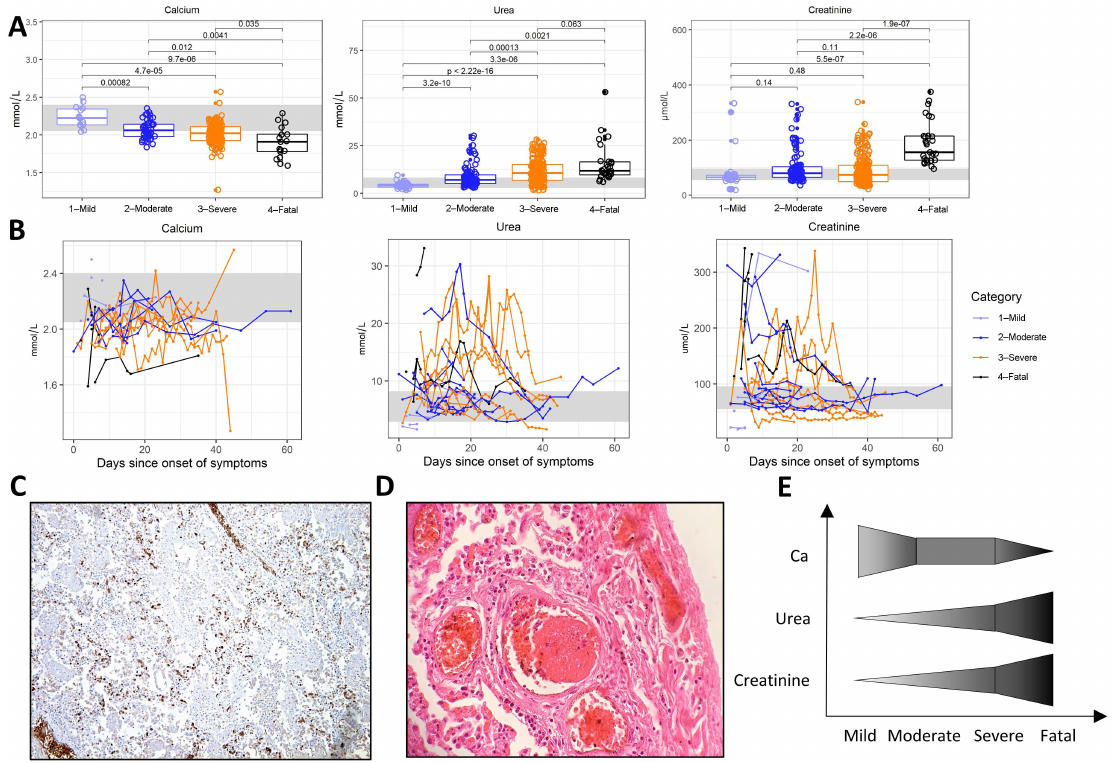
Figure 4. Kidney failure and lung damage. ( A ) Calcium, urea, and creatinine levels in patients with mild, moderate, severe, and fatal courses of the disease. ( B ) Dynamics of calcium, urea, and creatinine levels in patients with mild, moderate, severe, and fatal courses of the disease over time. ( C ) Immunohistochemical staining of IL-6 in a COVID-19 patient lung necropsy (4 × magnification) showing IL-6-producing cells within the interstitium and capillaries of interalveolar septa and within the lumen of larger vessels. ( D ) Hematoxylin and eosin staining of a COVID-19 patient lung necropsy (20 × magnification) showing interstitial pneumonia and the details of a venous thrombus. ( E ) Comparison of trends between individual parameters shown in ( A ). Boxes depict the median and first and third quartiles, and whiskers show the 2.5th and 97.5th percentiles. Each symbol represents a unique measurement. Multiple measurements at di ff erent time points are included for all patients. Values shown are the Student’s t -test p -values with Holm’s multiple comparison adjustments. Where available, a healthy reference range for adult males is shown in light